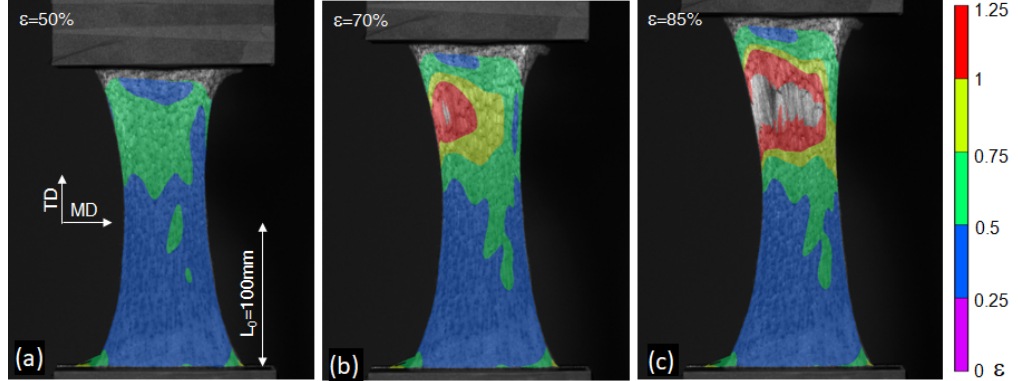
Figure 4. Contour plots of the logarithmic strain in the loading direction at different applied strains ( a ) 50%, ( b ) 70% and ( c ) 85%